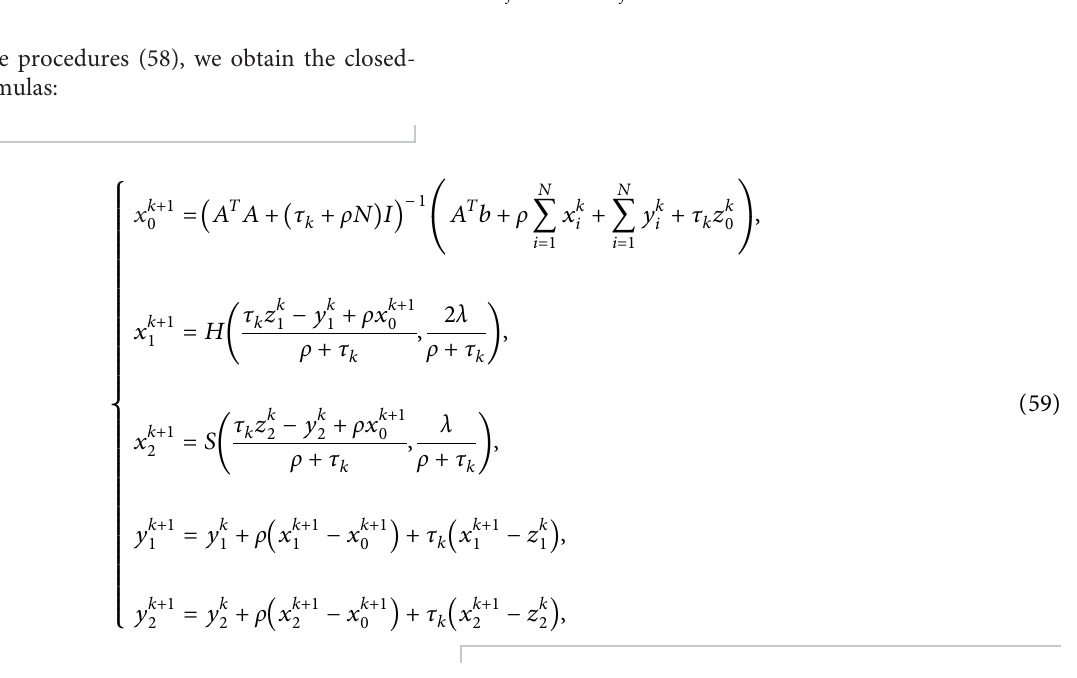
� 3 l 2 − 2 θρ − l 2 k f / ρ